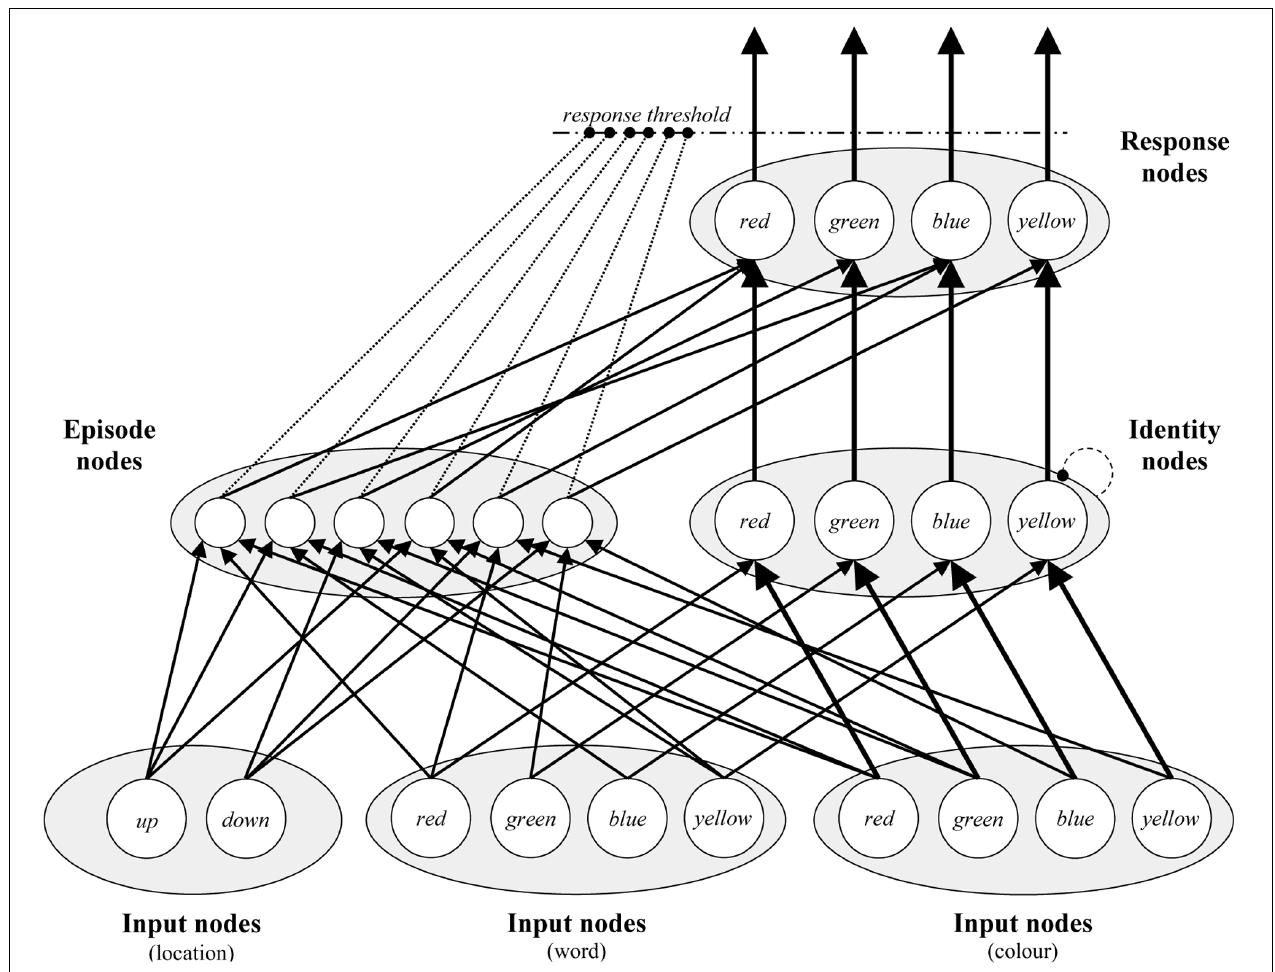
FIGURE 4 | A visual depiction of the Parallel Episodic Processing (PEP) model. There are Input nodes for each location, word, and color. Input nodes feed activation to Identity nodes, where conflict can occur between color words and colors. Identity nodes feed activation to Response nodes, where a response is selected. Via Episode nodes, locations, words, and colors activate the responses that they are connected to, in addition to affecting the response threshold dynamically. Connections ending in circles indicate